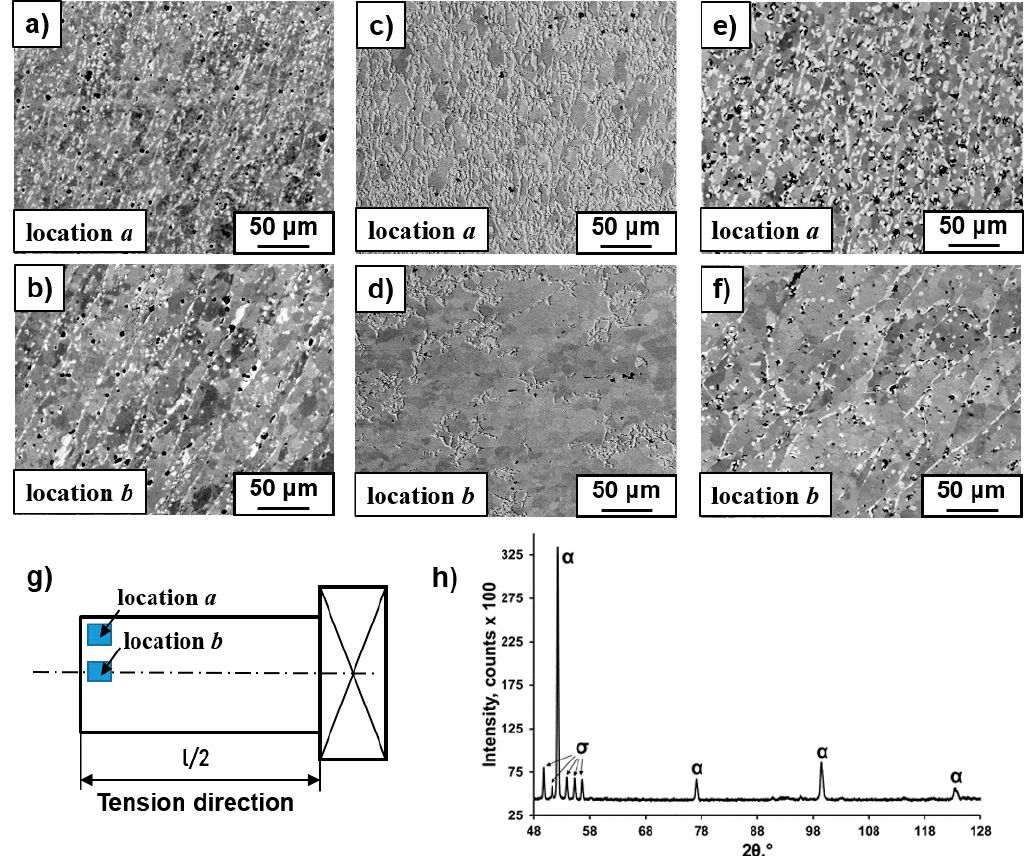
Figure 1. SEM images of the microstructure at the surface ( a , c , e ) and in the volume ( b , d , f ) of the samples deformed at 750 ( a , b ), 800 ( c , d ), and 850 °C ( e , f ) after nine rotations of torsion and 20% tension. The σ -phase has bright contrast in comparison with the dark α -phase in the SEM images obtained in back-scattered electron mode (BSE). The scheme of microstructure observations in SEM ( g ). XRD pattern of the alloy deformed at 800 °C ( h ).